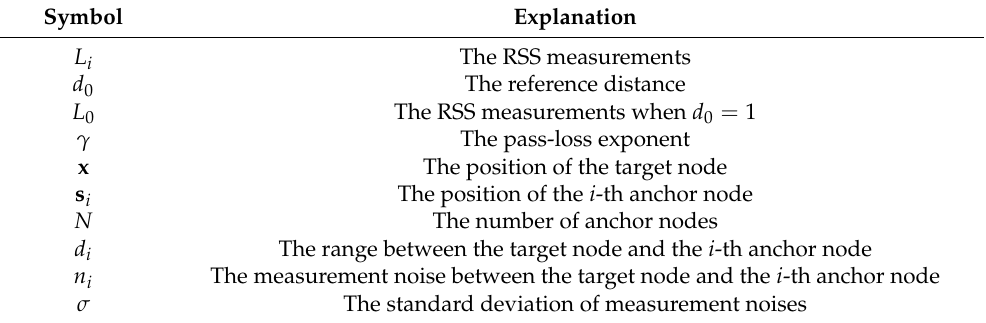
Table 1. Symbols and